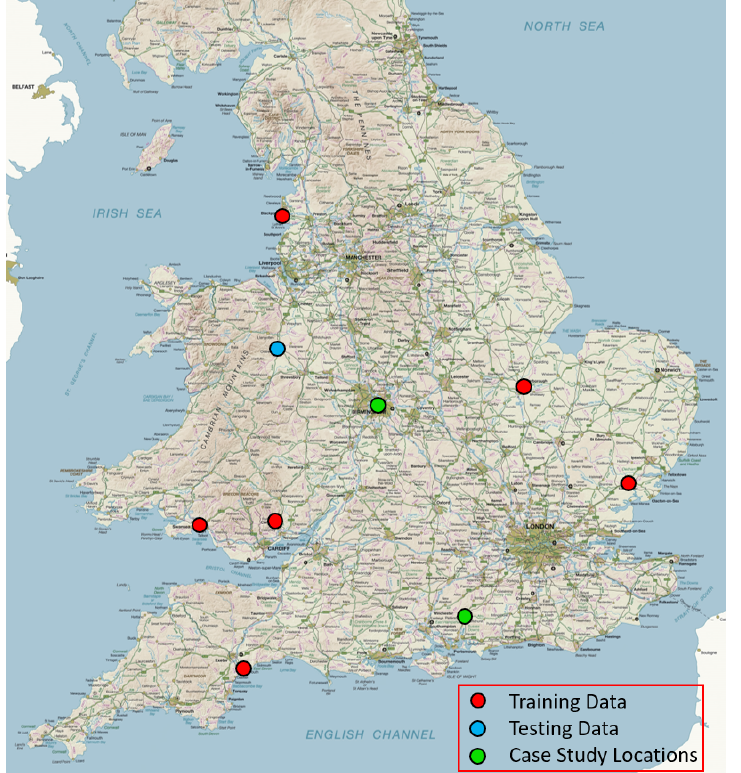
Figure 3. A map showing the locations of the towns and cities from which the training and testing data are sourced. This image is adapted from the following source http://ontheworldmap.com/uk/ england/map-of-england-and-wales.html (accessed on 8 March